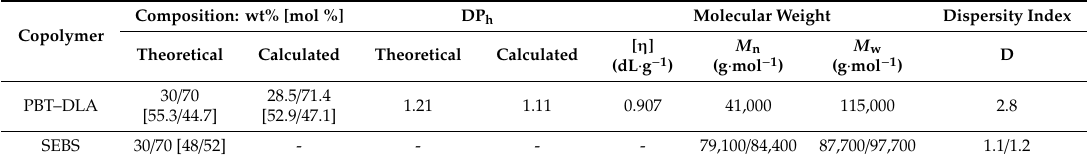
Figure 3. 13 C NMR spectra of PBT–DLA copolymer with a magnified region characteristic for carbons present in carbonyl groups. Table 2. Composition, degree of polymerization of hard segments and malar masses of PBT–DLA copolymer in comparison with commercial SEBS block copolymer